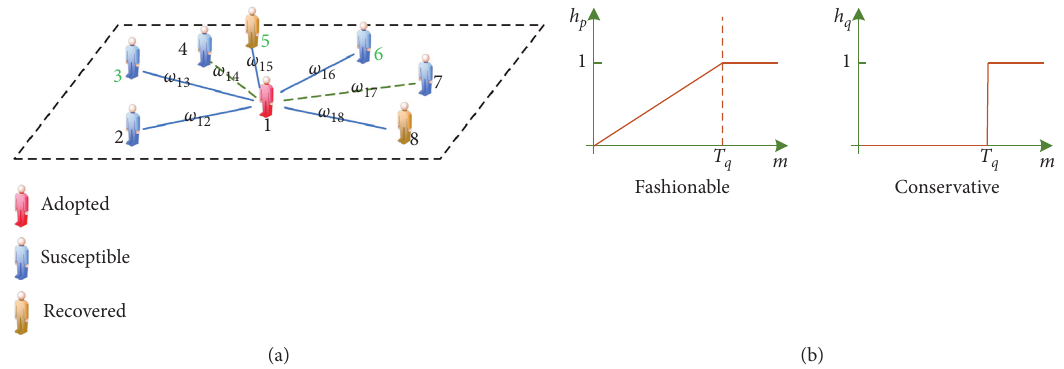
Figure 1: (a) The illustration of the SAR model on the weighted network. The green labels represent that the individuals are fashionable, such as individuals 3, 5, and 6. The black labels represent conservatives, such as individuals 1 and 2. The symbol ω is edge weight. At time t , A-state individual 1 propagates information to its neighbors. The green dashed lines imply that information cannot be transmitted via the edges. The blue solid lines indicate information has not been transmitted through the corresponding edges. (b) The left subgraph is the behavior adoption threshold model of fashionable individuals. The right subgraph is the behavior adoption threshold model of con- servatives. m is the aggregate pieces of information that the S-state individual successfully received. p and q are the fractions of fashionable and conservative individuals, respectively. T p and T q are the behavior adoption thresholds of fashionable and conservative individuals,